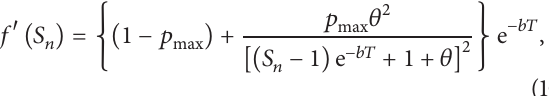
Figure 1: The effects of resource limitation parameter 𝜃 and pulse vaccination period 𝑇 on the threshold value 𝑅 1 0 with 𝑝 max = 0.75 . All other parameter values are given in Table